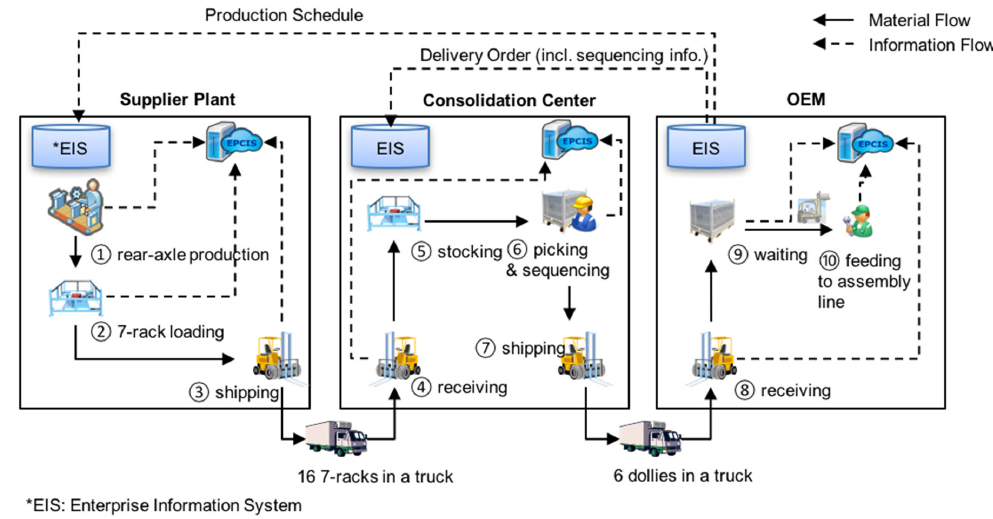
Figure 2. The overall supply chain process for rear axles.